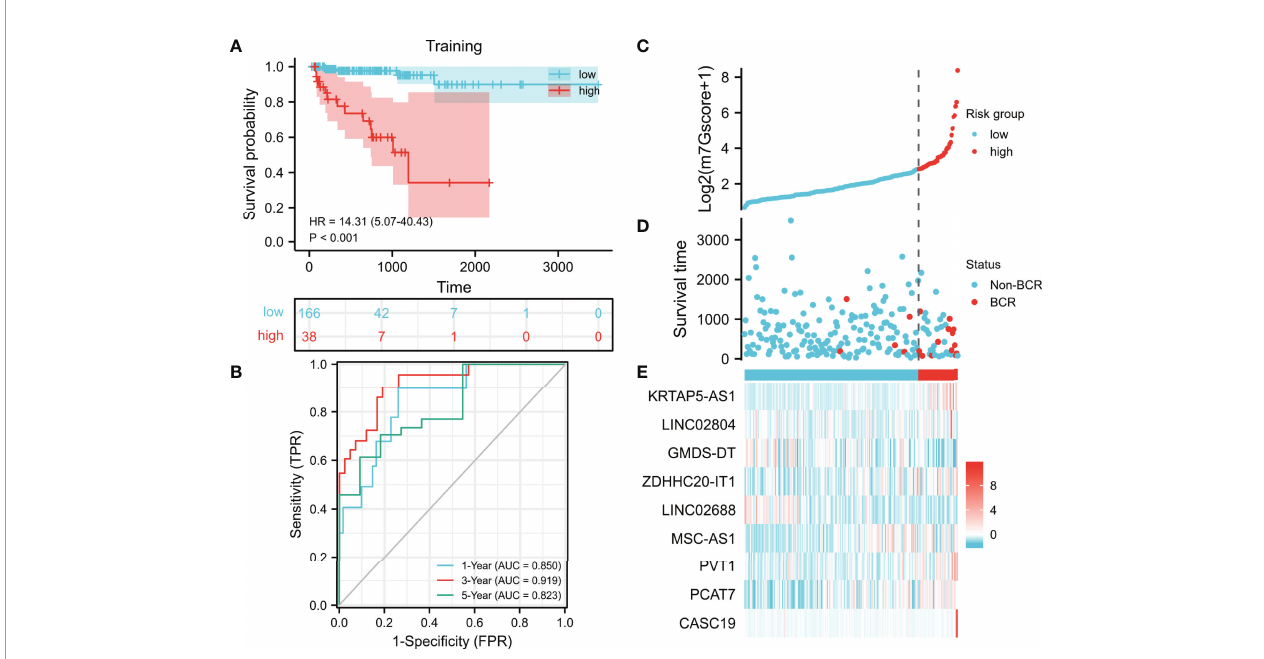
FIGURE 3 | Development and evaluation of the m7G model. (A, B) Evaluation of the m7G model with Kaplan – Meier analysis (A) and time-dependent ROC curves (B). (C – E) Distribution of m7Gscore (C) , BCR status (D) , and model consisting of m7G-related lncRNAs (E) . m7G, 7-methylguanosine; ROC, receiver operating characteristic; BCR, biochemical recurrence.